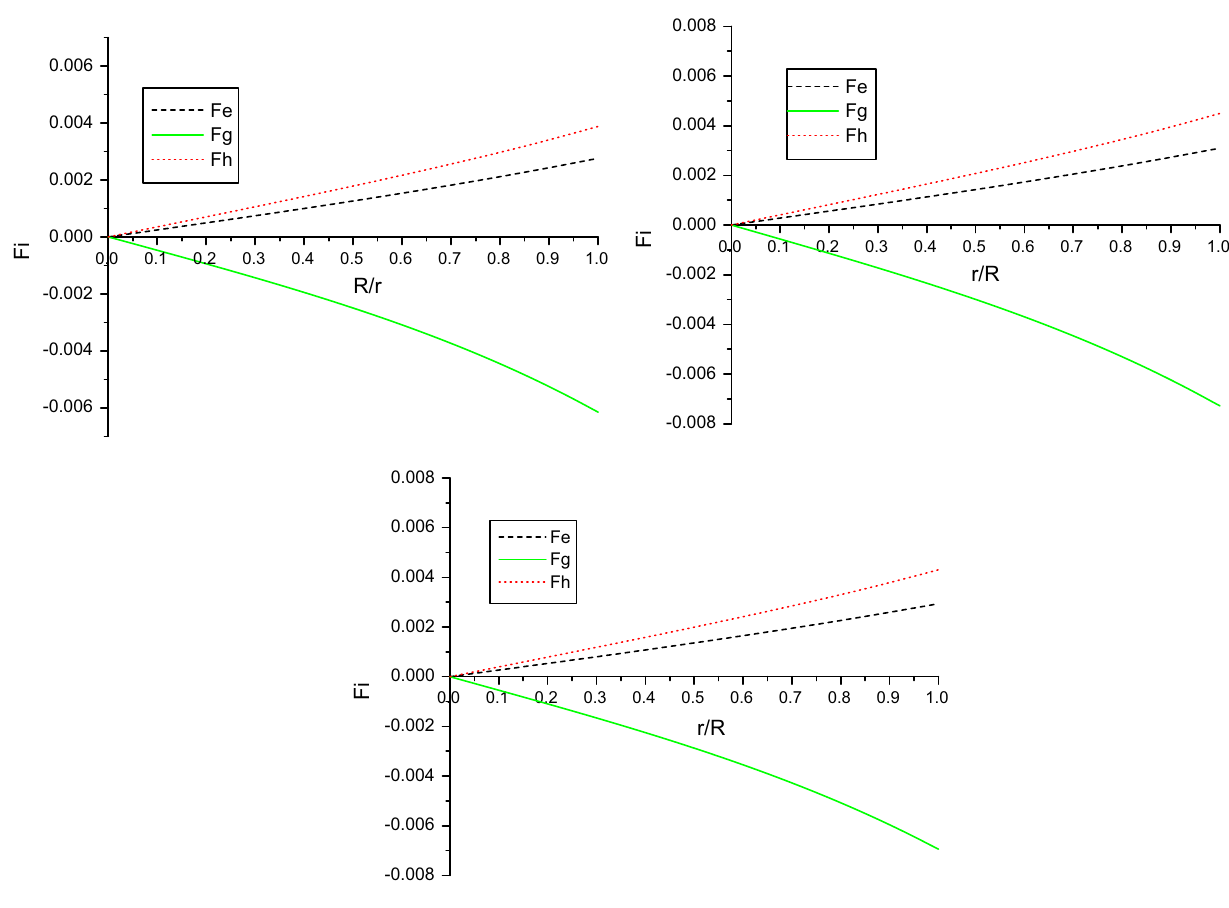
Fig. 2 We have plotted different forces, namely, gravitational ( F g ) , hydrostatic ( F h ) and electric forces ( F e ) , respectively, to describe the equilibrium condition for charged fluid sphere. The result shows that